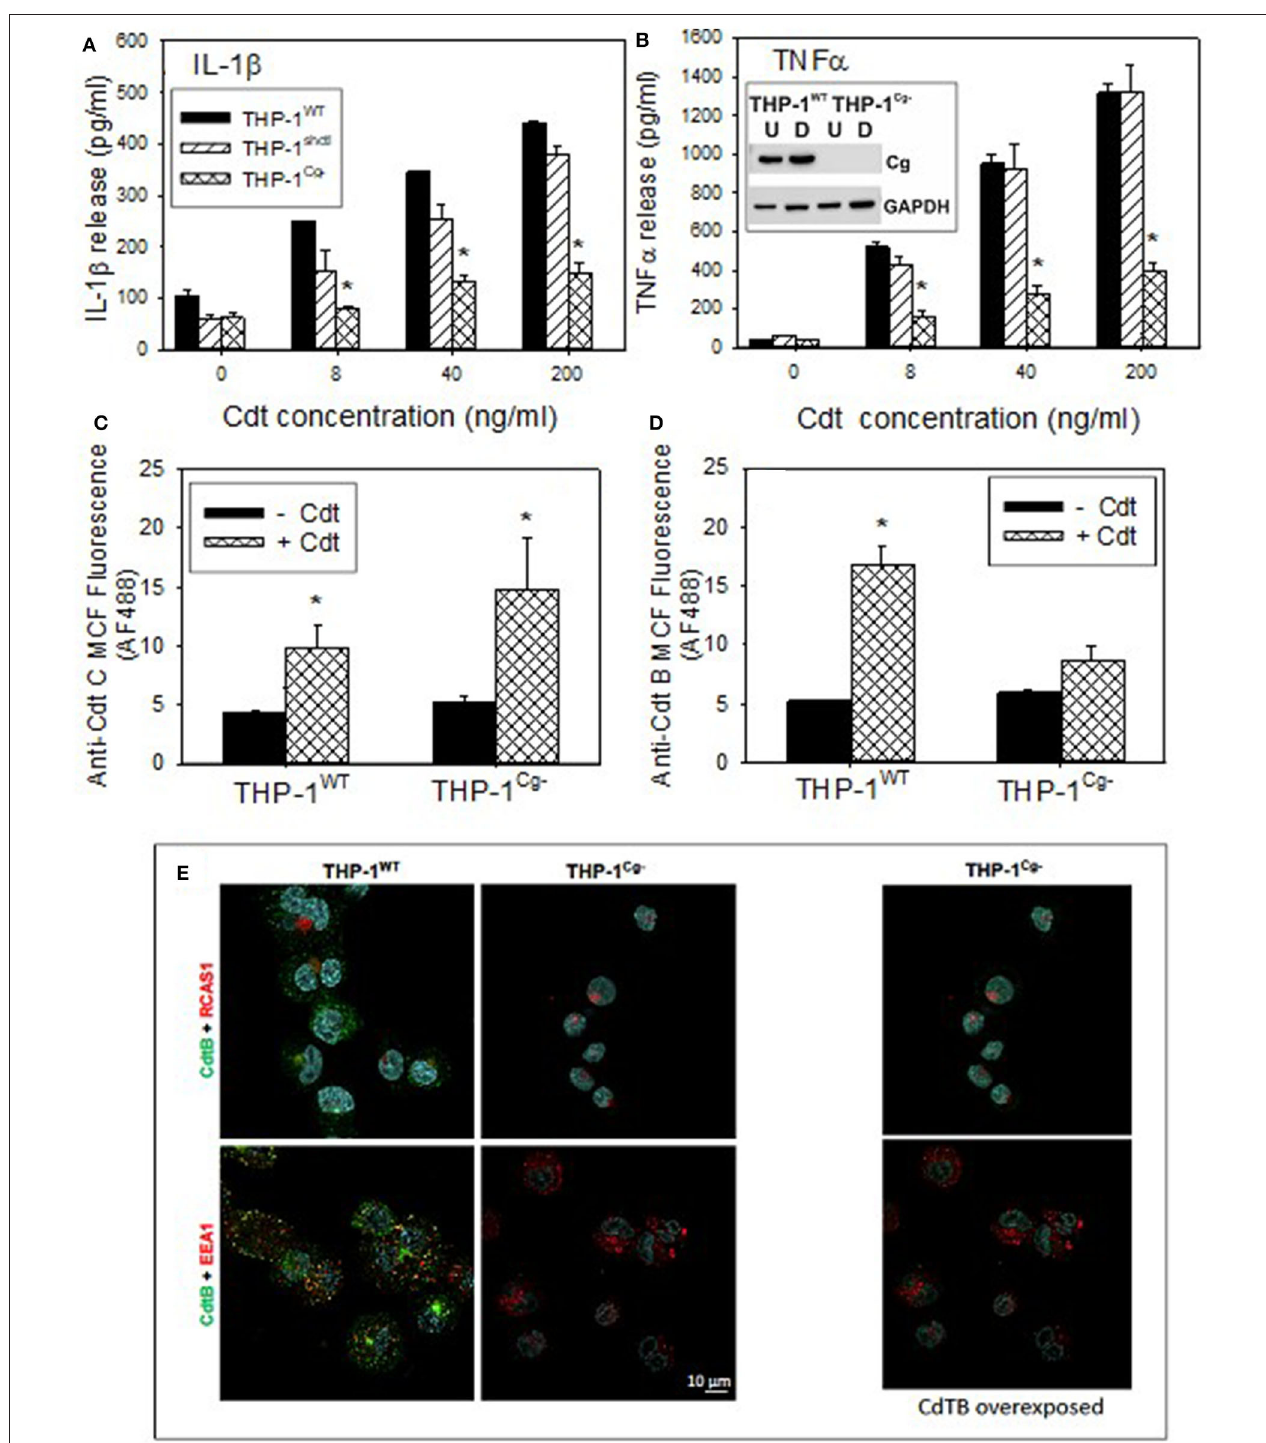
FIGURE 5 | Comparison of THP-1 WT - and THP-1 Cg − -derived macrophages on susceptibility to Cdt-induced pro-inflammatory response, Cdt holotoxin binding and CdtB internalization. (A,B) Macrophages derived from THP-1 WT (solid bars) THP-1 schctl (hatched bars) and THP-1 Cg − (cross-hatched bars) cells were treated with varying amounts of Cdt for 5h; supernatants were harvested and analyzed by ELISA for IL-1 β (A) and TNF α (B) . Data are plotted as the mean ± SEM (pg/ml) and represent the results from three experiments. Inset in (B) shows Western blot analysis of cellugyrin in undifferentiated (U) and differentiated (D) cells derived from